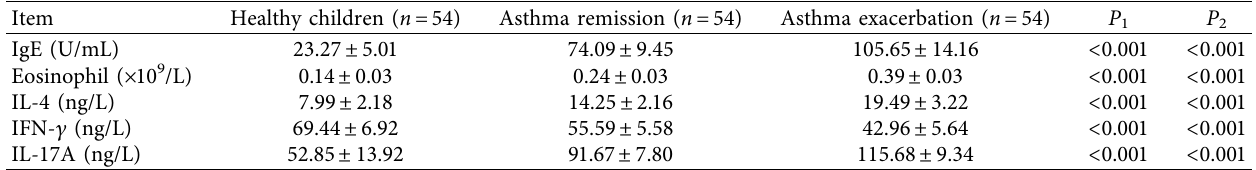
Figure 3: Pearson correlation analysis of the expression level of LINC00847 with lung function of asthma children. Table 2: The IgE concentration, eosinophil count, IL-4, IFN- c , and IL-17A of asthma exacerbation children, asthma remission children, and healthy children.